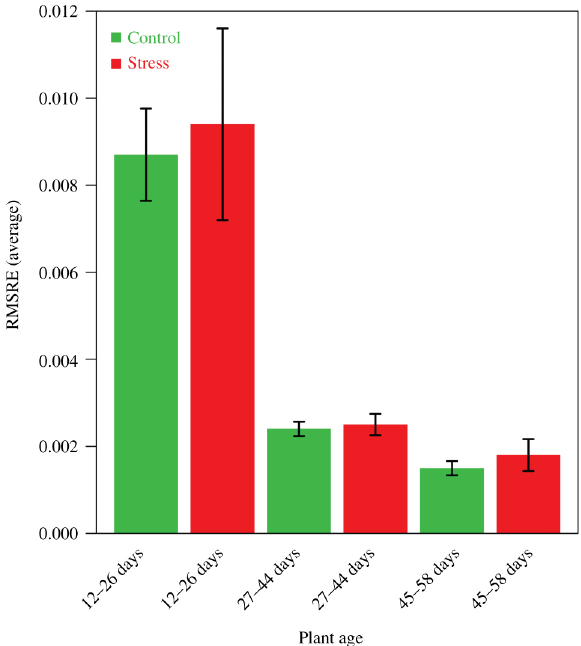
Figure 5: Prediction accuracy of the proposed model in terms of time after planting (plant age). Average estimation error (RMSRE) of the proposed model in terms of plant